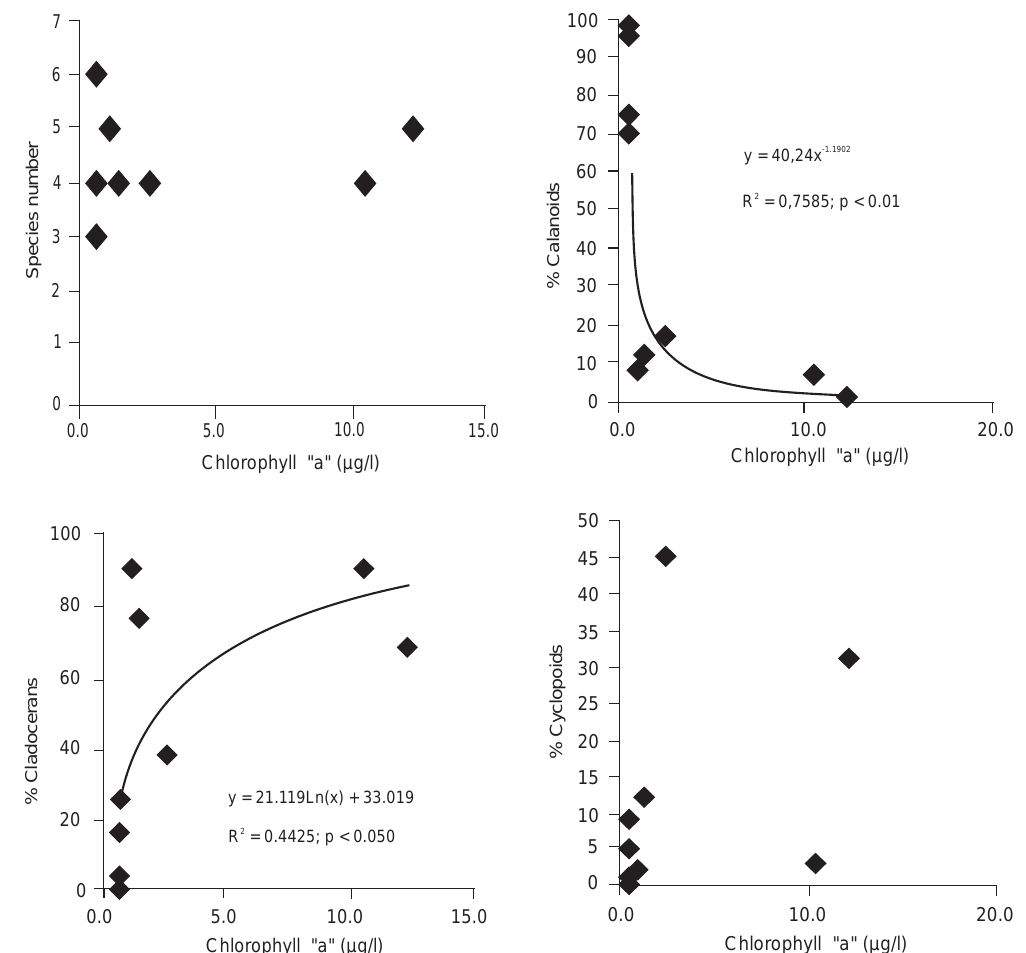
Figure 1. Graph of associations between species number, calanoid, cladoceran and cyclopoid percentage with chlorophyll concentra- tion for studied